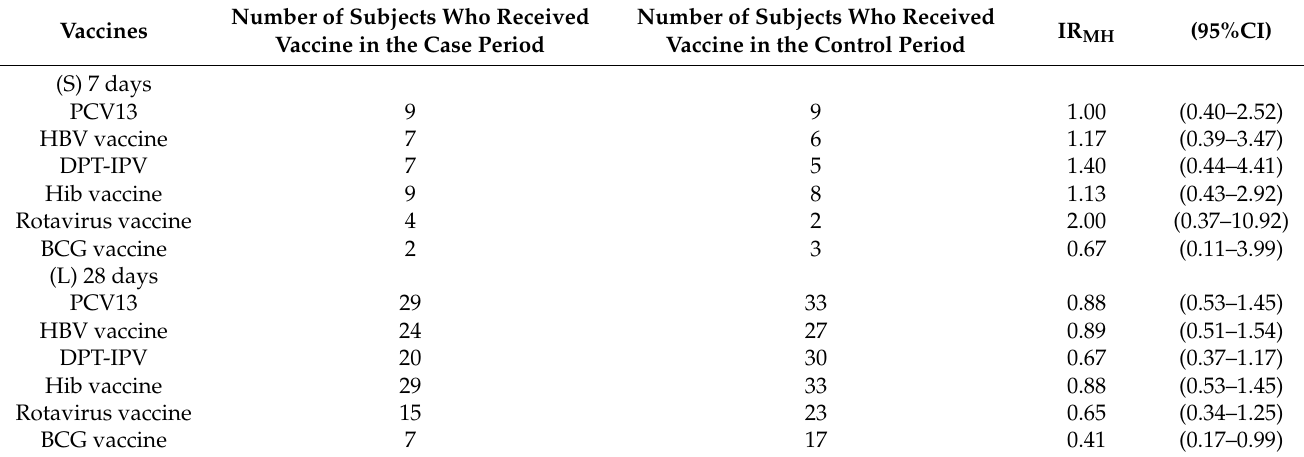
Table 3. Case-crossover study on vaccination in patients with